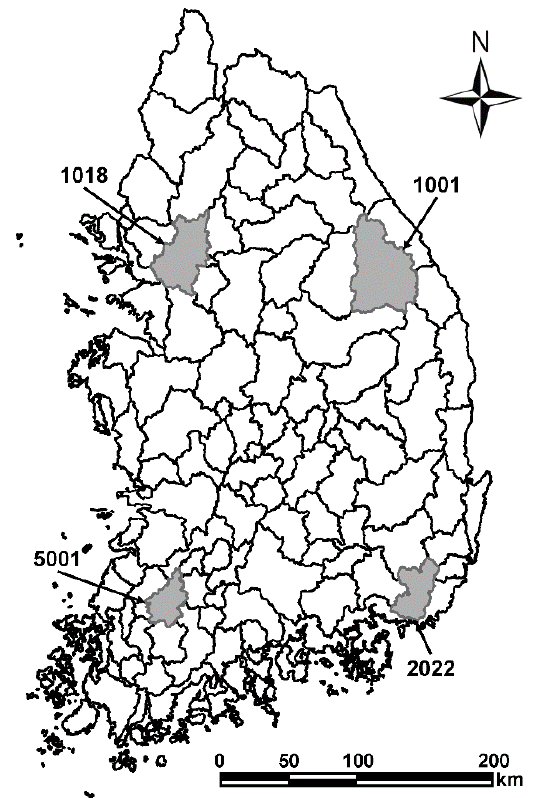
Figure 1. Four test catchments considered in this